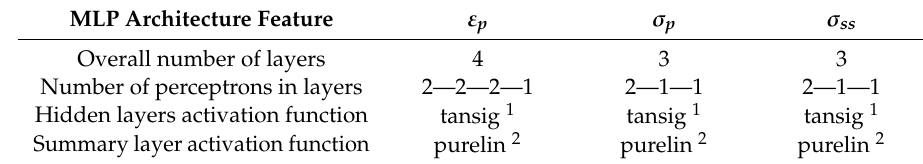
Figure 3. An influence of network architecture on a value of mean squared error. ( a ) Peak strain description—1 hidden layer; ( b ) peak strain description—2 hidden layers; ( c ) peak stress description—1 hidden layer; ( d ) peak stress description—2 hidden layers; ( e ) steady-state stress description—1 hidden layer; ( f ) steady-state stress description—2 hidden layers. Table 1. Architecture features of adapted Multi-Layer Perceptron (MLP) networks.